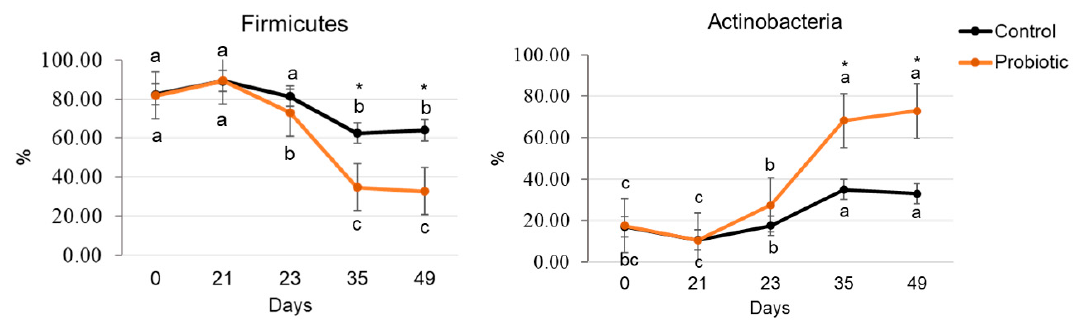
Figure 3. Relative abundance of the main bacterial phyla in feces of dogs fed a lower protein and fiber diet (day 21) transitioned to a higher protein and fiber diet (days 23 to 49) without (control) or with (probiotic) yeast supplementation (S). a,b,c Different superscript letters near control and probiotic groups indicate differences among days by the LSD Bonferroni test in each group ( p < 0.05). * Indicates difference between the control and probiotic groups at the time point ( p < 0.05).